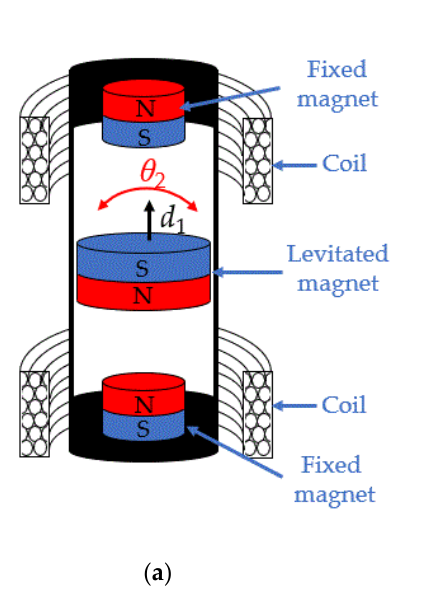
Figure 2. Magnetic spring: ( a ) section view of coils, fixed and levitated magnets, ( b ) 2-DoF kine- matic chain.